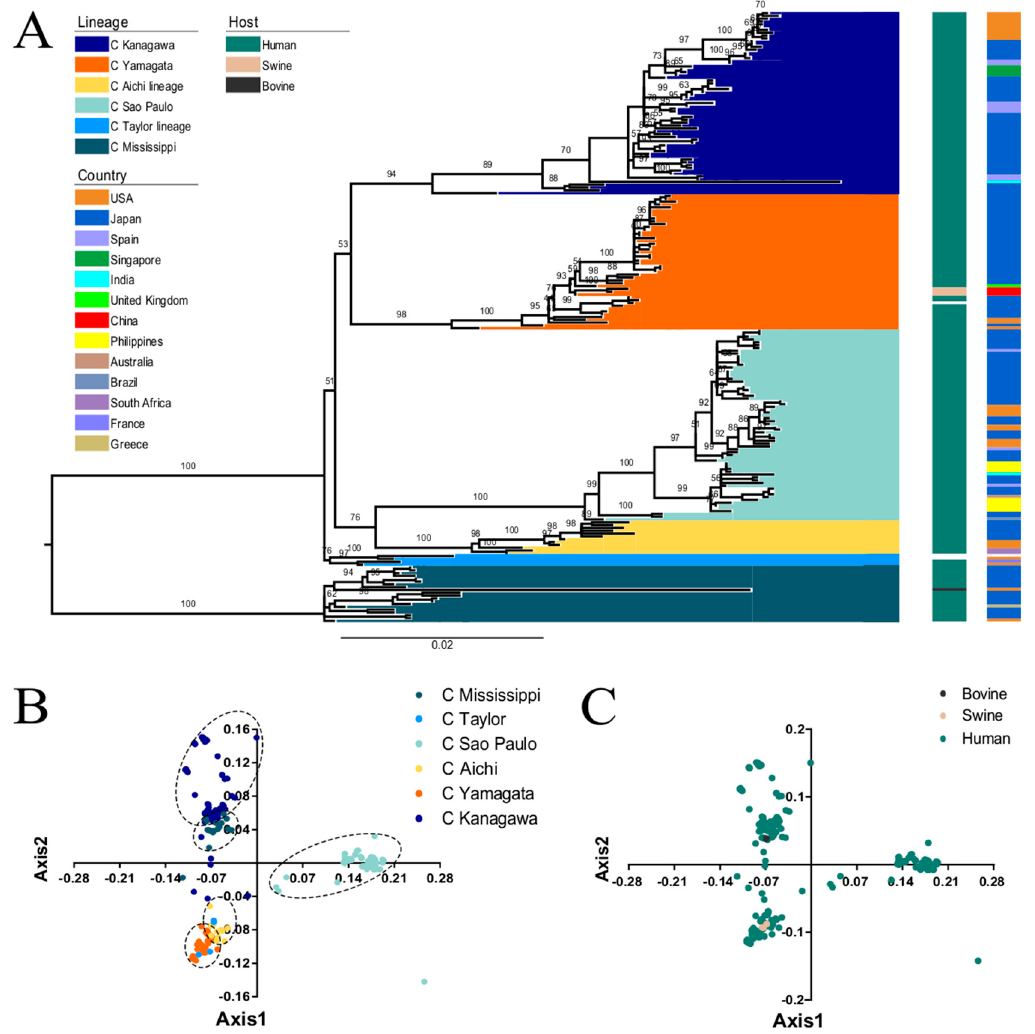
Figure 1. ( A ) ML phylogenetic tree of the ICV HE gene reconstructed in RAxML (_v8.2.10) using the GTR + GAMMA + I model and supported by 1000 bootstraps. The observed six individual lineages: C/Kanagawa, C/Yamagata, C/Aichi, C/Sao Paulo, C/Taylor, and C/Mississippi lineages are represented in dark blue, orange, light green, yellow, light blue and cyan, respectively. Coloured boxes along the right of the tree represent the hosts and countries of isolation. The host species coloured in dark green, light brown, and dark grey represent human, swine, and bovine, respectively. The individual countries are indicated with different colours. The no-coloured regions denote no related information recoded in NCBI. PCA analysis explained with the first two axes. ( B ) PCA according to the six evolutionary lineages (colours codes same as A). ( C ) PCA according to the isolated host species (colours same as A).